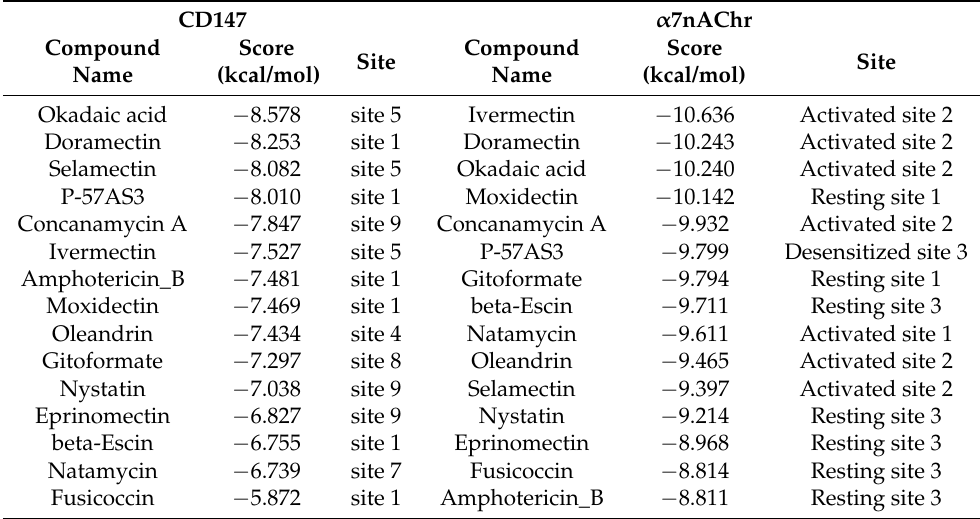
Table 3. Results of the docking analysis on CD147 and α 7nAChr. Compounds are sorted in descend- ing order according to |Score| separately for CD147 and α